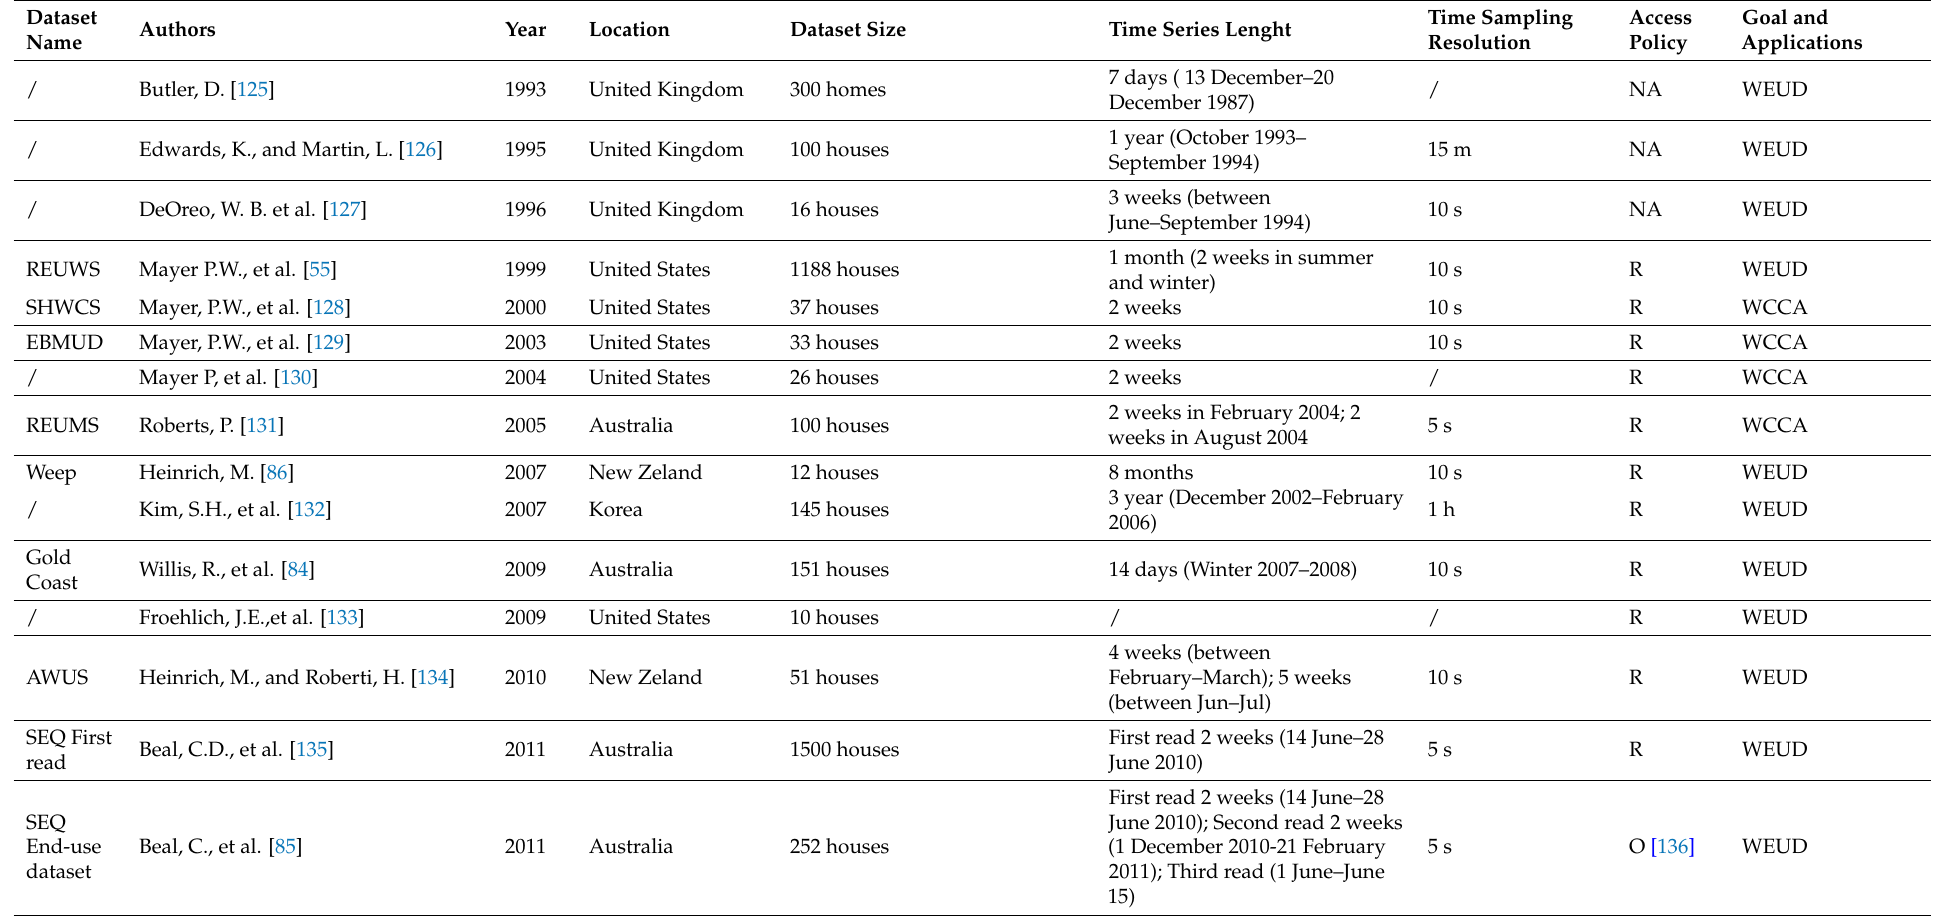
Table 3. Metadata of the 41 reviewed datasets at the end use scale. Different goals and applications are considered (see last column): WEUD = Water End Use Disaggregation; WCCA = Water Conservation and Customer